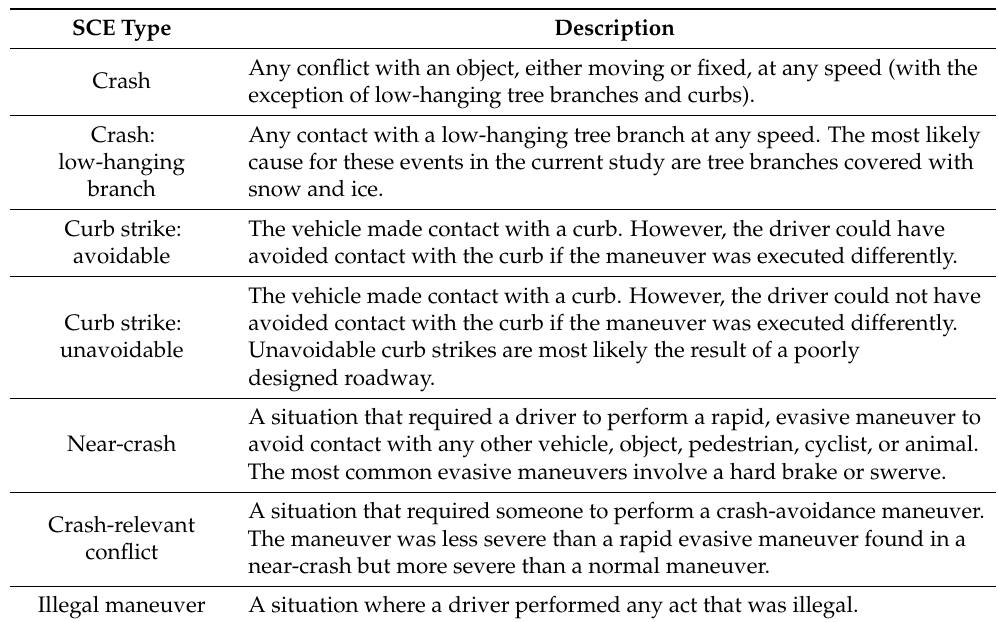
Table 1. Description of each type of SCE